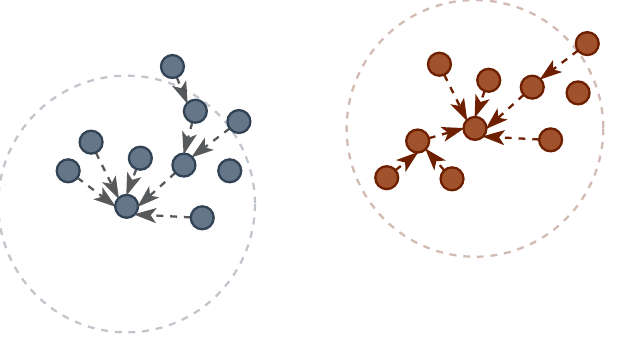
Figure 3. The brown and grey points indicate the embedding of two different classes. The strong can-link pairs are generated by calculating the nearest neighbors of each data point. Strong can-link pairs introduce diverse features to the embedding model and can increase cluster density. Due to strong link pairs, the closer embedding points (brown/grey) move towards a dense region forming individual